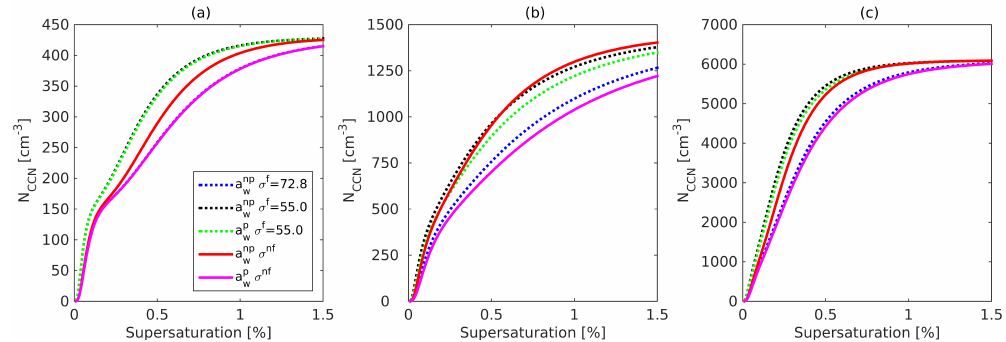
Figure 3. CCN spectra calculated from true parameter values (Table 2) for (a) marine average, (b) rural continental, and (c) polluted continental environments. Models using a fixed surface tension value are shown by dotted lines, while models using Eq. (9) are presented with solid lines.